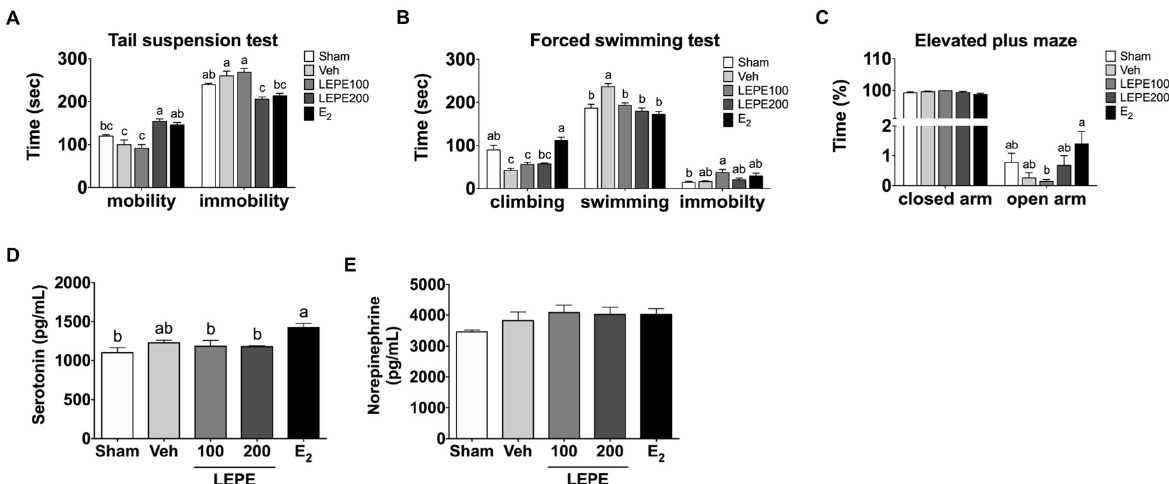
Figure 4. The effect of LEPE on improving menopause-related depression based on behavioral tests and blood hormone levels. ( A ) Time of mobility and immobility in the tail suspension test, ( B ) time spent climbing, swimming, and immobility in the forced swimming test, ( C ) time spent in the closed and open arms in the elevated plus-maze ( D ) serotonin and ( E ) norepinephrine levels in the serum. Sham, control sham-operated rats; Veh, ovariectomized (OVX) rats treated with vehicle; LEPE100, OVX rats treated with Leonurus japonicus Houtt, Eclipta prostrata L., and Pueraria lobata Ohwi extract (LEPE) 100 mg/kg bw; LEPE200, OVX rats treated with LEPE 200 mg/kg bw; E 2 , positive control, OVX rats injected with estradiol 3.0 µ g/kg bw. Data are shown as mean ± SEM ( n = 12). a–c Significant differences were analyzed by one-way ANOVA with Tukey’s multiple comparisons between groups ( p < 0.05).